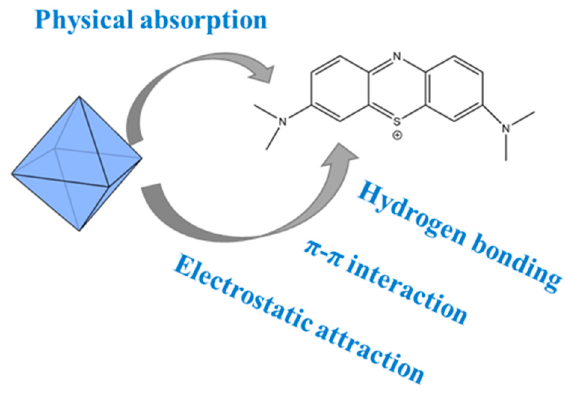
Figure 9. Possible adsorption mechanism of